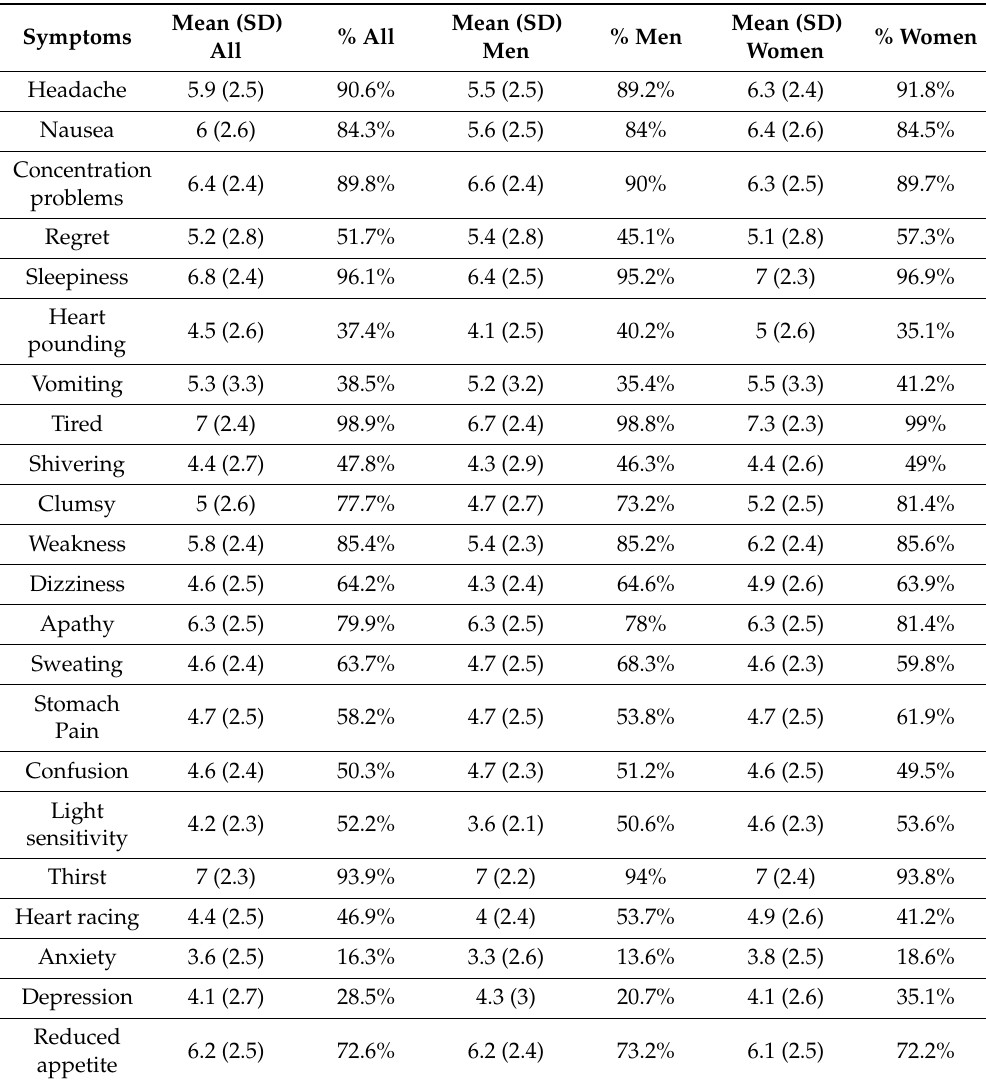
Table 7. Presence and severity of individual hangover symptoms after alcohol consumption and reaching an eBAC of 0.3% ≤ eBAC <